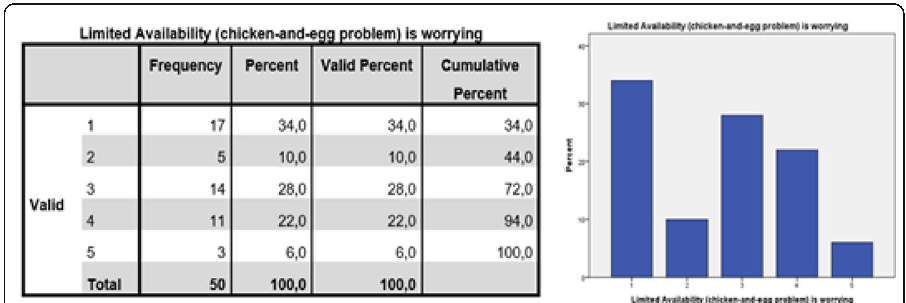
Fig. 2 Limited Availability (the chicken-and-egg dilemma) is worrying. Source: by